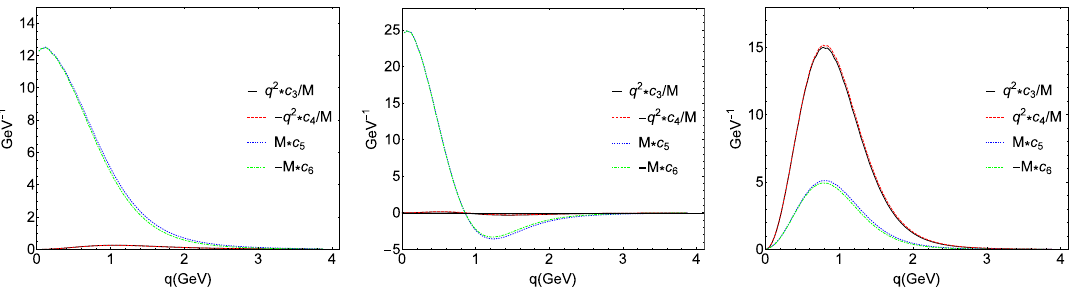
(1 S ) (left), B ∗ (2 S ) (middle) and the S − P − D mixture c c